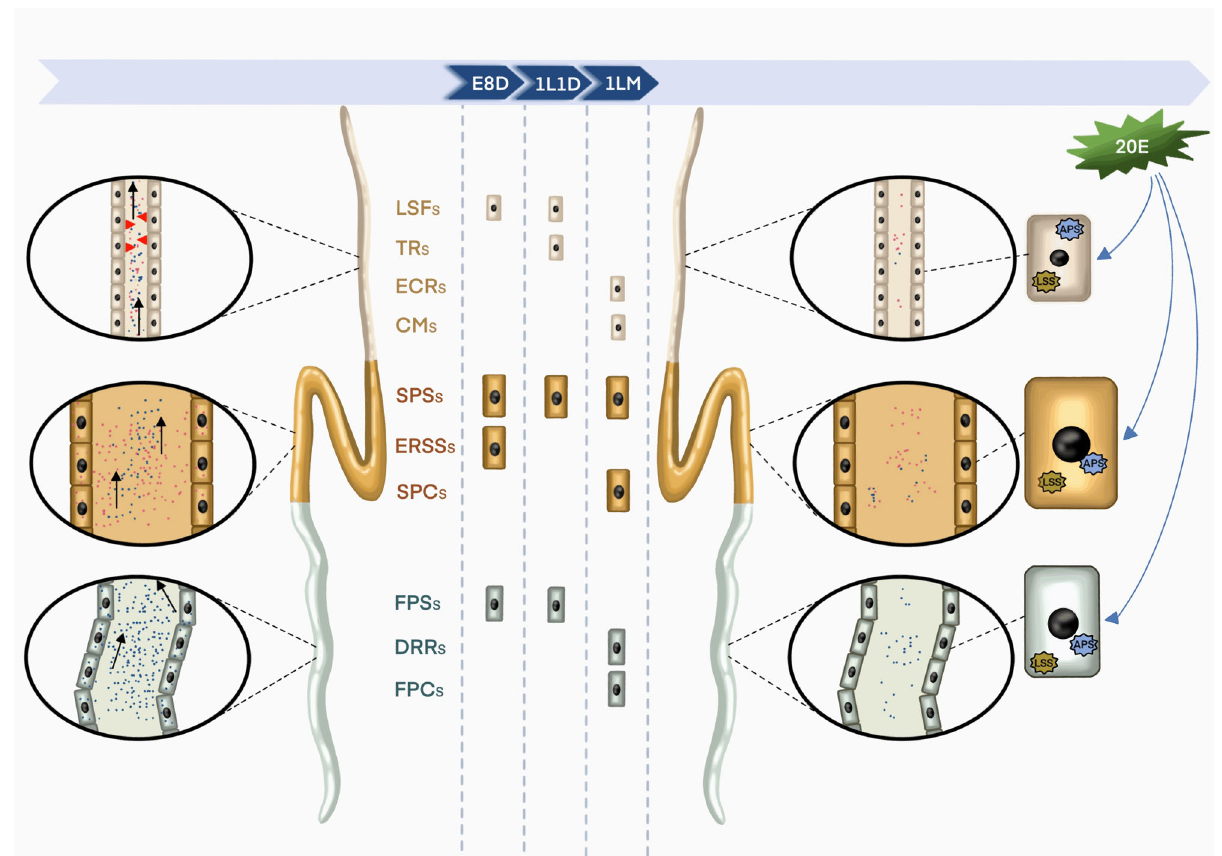
Fig. 8 Depicting the composition of major cell types in silkworm silk glands. Cell types in the anterior silk gland, middle silk gland, and posterior silk gland are distinguished in light brown, gold, and white, respectively. Liquid silk fi brosis cells (LSFs), sericin protein-synthesizing cells (SPSs), endoplasmic reticulum stress signaling cells (ERSSs), and fi broin protein-synthesizing cells (FPSs) appeared at E8D; LSFs, SPSs, FPSs, and traction forces cells (TRs) appeared at 1L1D; SPSs, FPSs, epithelial cell remodeling cells (ECRs), chitin metabolism cells (CMs), sericin protein catabolism cells (SPCs), death and remodeling regulation cells (DRRs), and fi broin protein catabolism cells (FPCs) appeared at 1LM. Interestingly, ERSSs were E8D-speci fi c, TRs were 1L1D- speci fi c, and ECRs, CMs, SPCs, DRRs, and FPCs were 1LM-speci fi c. The black arrow represents the direction of silk protein transport and the red arrowhead represents shear force. Magni fi ed images of the corresponding silk glands are shown in black panes (both sides). An enlarged view of single cell at 1LM modulated by 20E signaling is shown on the right. Blue dots: silk fi broin; red dots: sericin; APS: autophagosome; LSS: lysosome. E8D 8 days post-egg